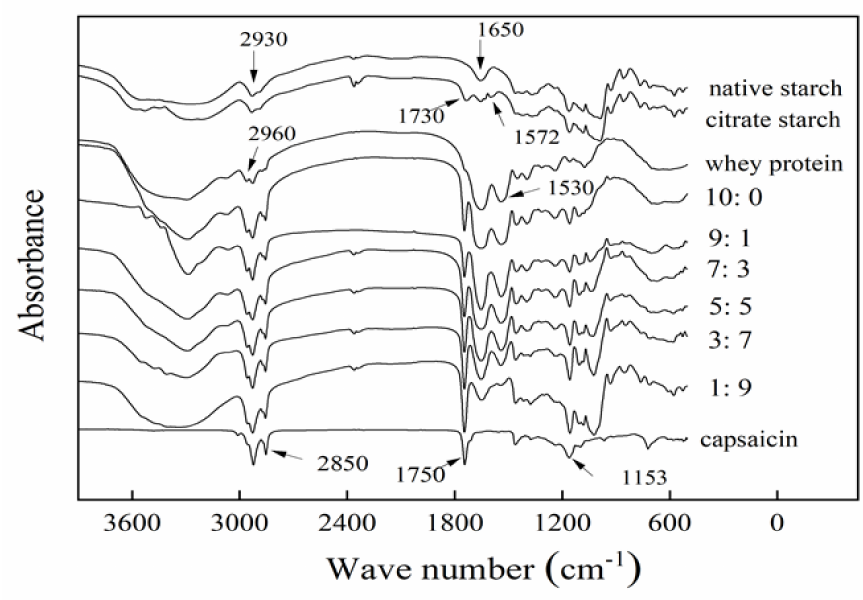
Figure 3. FTIR spectra of whey protein-citrate starch-capsaicin microcapsules. The labels 10:0, 9:1, 7:3, 5:5, 3:7, and 1:9 represent the ratio of whey protein to citrate mung bean